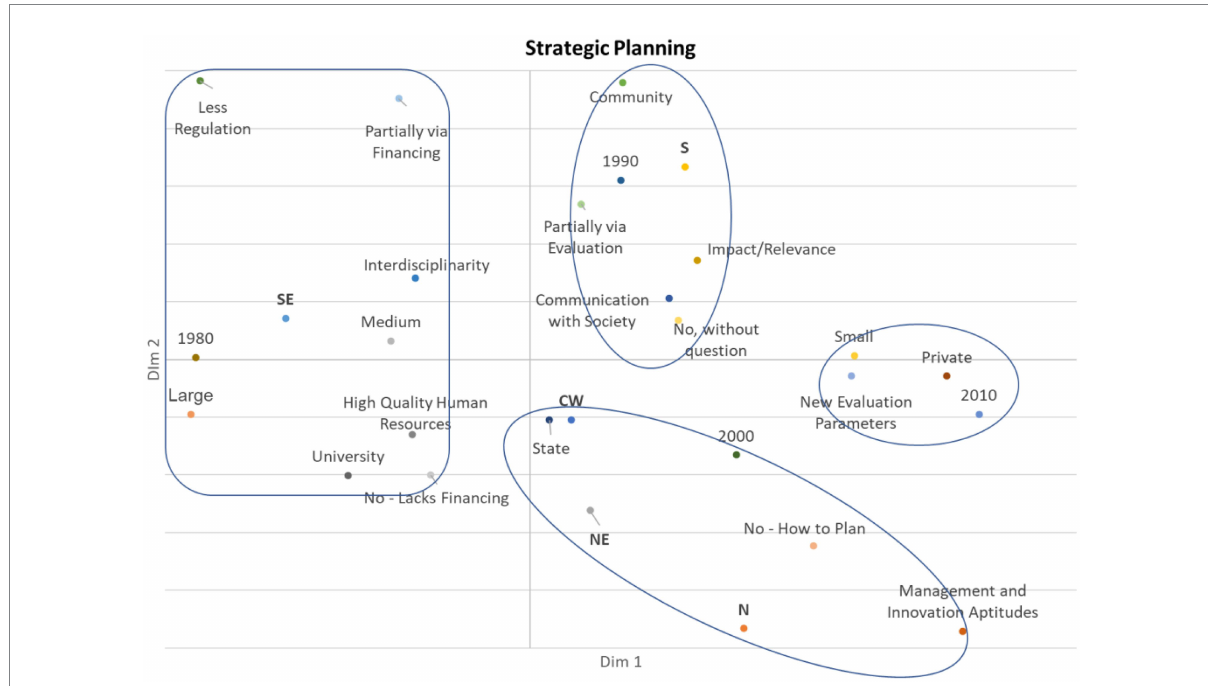
FIGURE 2 Correspondence analysis of Deans’ perception of strategic planning in the evaluation model (Region: CW, Centre-west; N, North; NE, Northeast; S, South; SE,